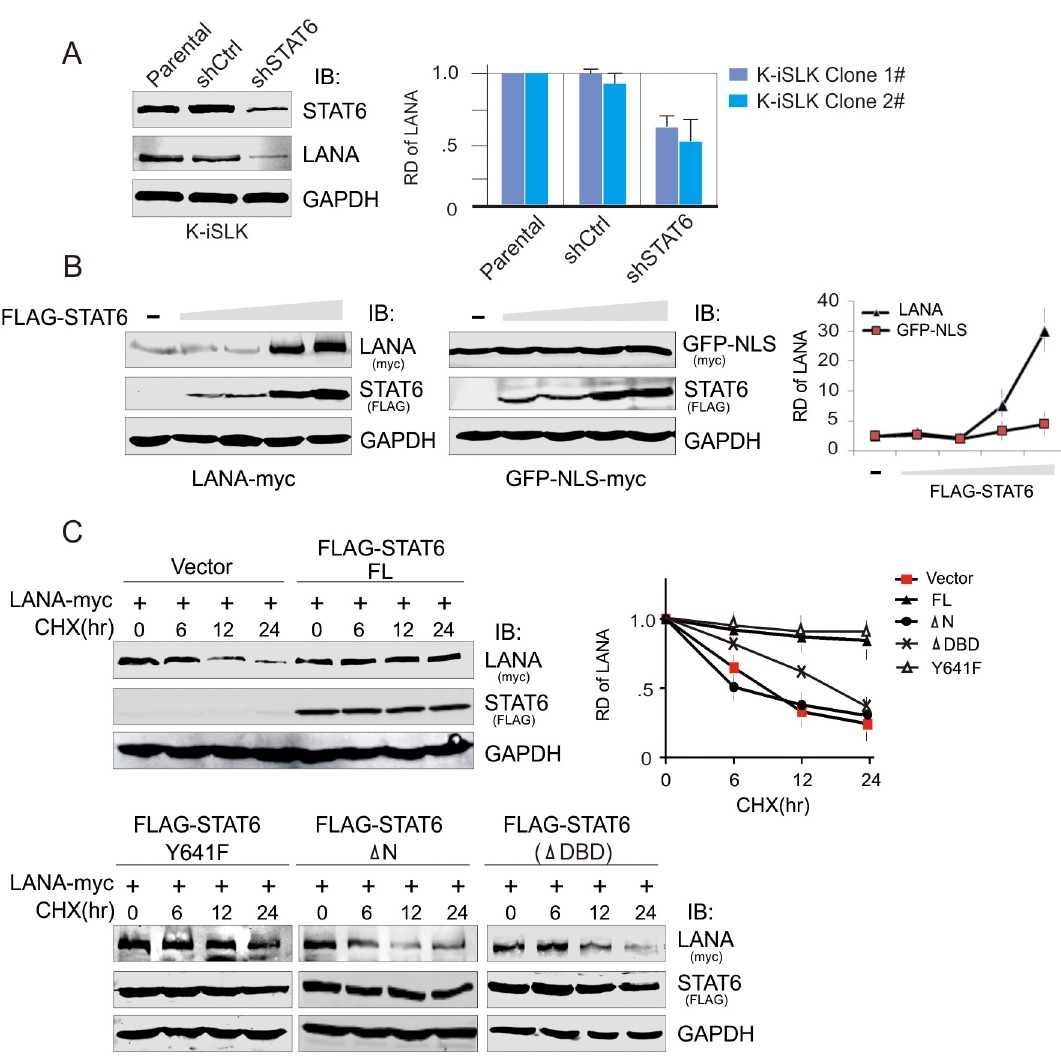
Fig 5. STAT6 contributes to the protein stability of LANA. ( A ) Knockdown of STAT6 reduces the expression level of endogenous LANA in KSHV-infected cells. Parental and K-iSLK cells with lentivirus-mediated knocked down of STAT6 (shSTAT6) or luciferase control (shCtrl), were subjected to immunoblotting. The relative density (RD) of protein level of LANA protein was individually quantitated based on triplicate experiments from two independent clones and shown on the right panel. ( B ) STAT6 stabilizes LANA in a dose-dependent manner. HEK293T cells were co-transfected LANA-myc (2 μ g) with different dosages of FLAG-STAT6 (0, 1, 2, 5, 10 μ g). 48hr post-transfection, cells were harvested and lysed for immunoblotting as indicated. The CMV-driven promoter plasmid GFP-NLS-myc was used as a control. The relative density (RD) of protein level of LANA or GFP-NLS is quantified based on triplicate experiments and shown on the right panel. ( C ) STAT6 enhances the protein stability of LANA. HEK293T cells were co-transfected by LANA-myc with full length (FL) FLAG-STAT6, its mutants (Y641F, deletion with amino-domain Δ N or DNA-binding domain Δ DBD) or vector alone. 36hr post-transfection, cells were treated with Cycloheximide (CHX) 20 μ g/ml for the indicated time before harvesting and lysing for immunoblotting. The relative density (RD) of protein level of LANA is quantified based on triplicate experiments and shown at the right panel.